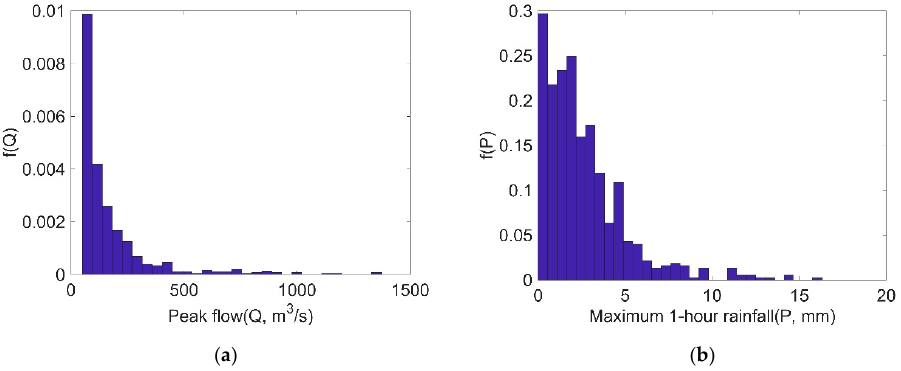
Figure 5. Frequency histograms. ( a ) Peak flow; ( b ) Maximum 1-h rainfall. Table 5. Performance of parametric methods for fitting marginal distributions of various floods. Various Distribution OLS AIC Gamma * Q